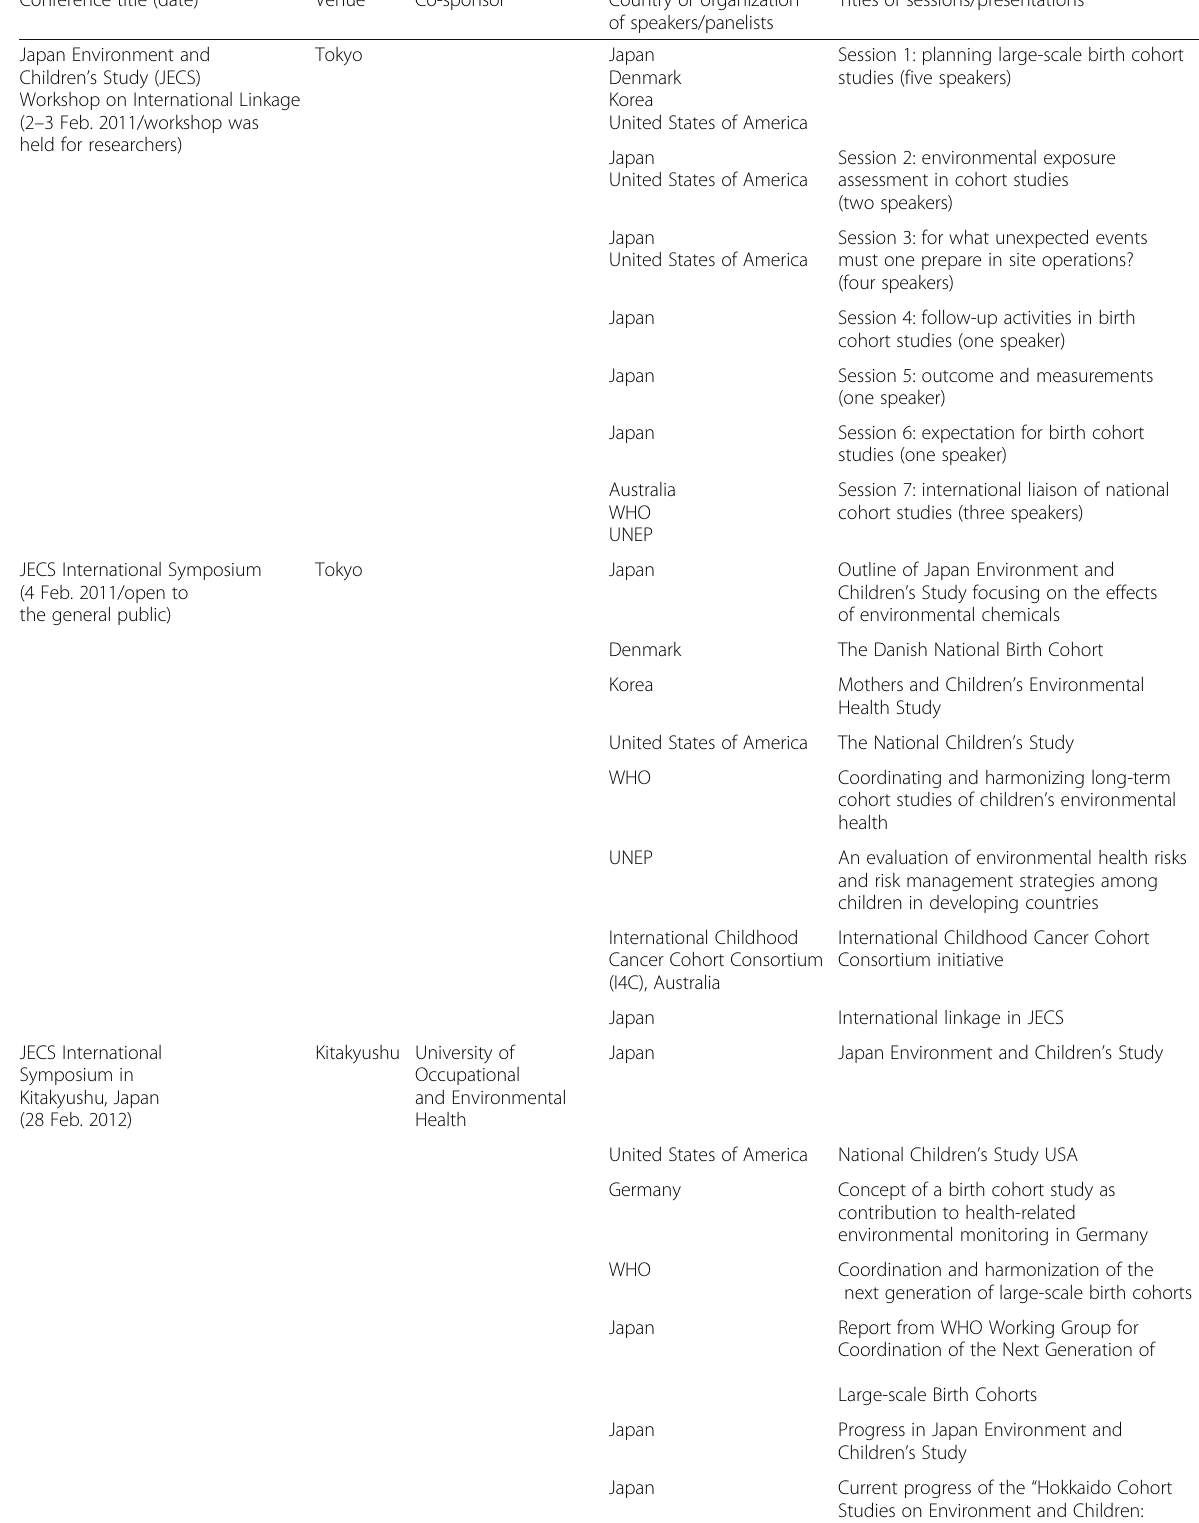
Table 1 JECS international